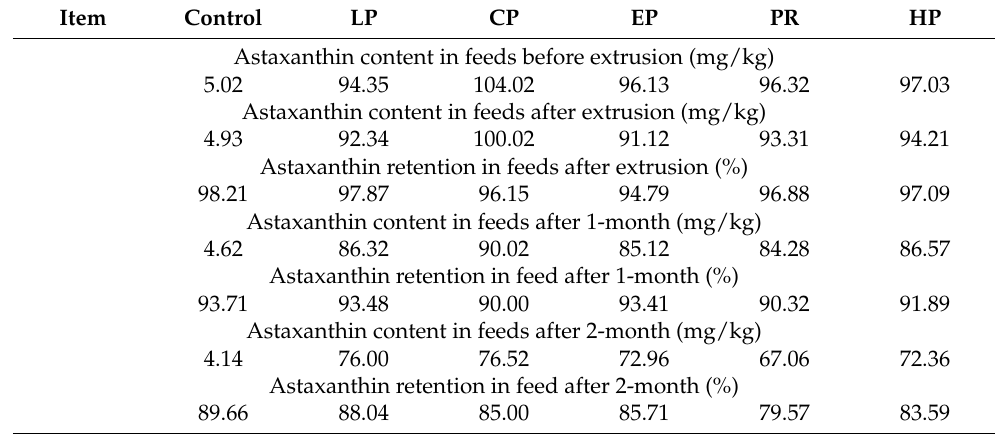
Table 5. Retention rates of astaxanthin in